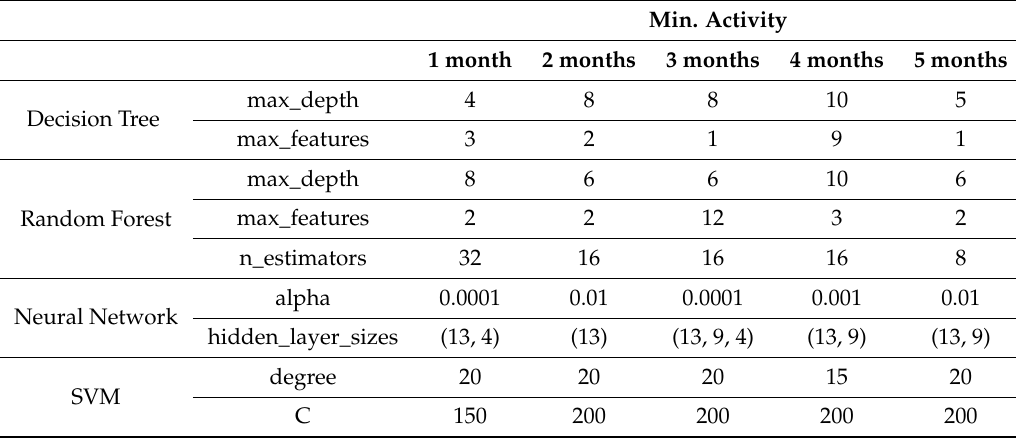
Table A22. The best values of the hyperparameters for the models which uses the full set of features for the manufacturing company dataset with two hierarchy